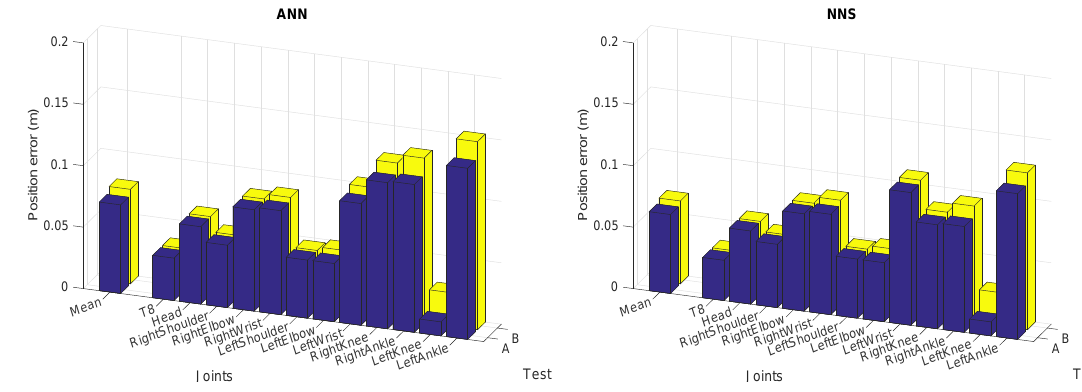
Figure 11. Mean (over all six subjects) joint position error obtained with ANN and NNS when the measured noise was applied to the heading orientation of the inputs. Here, A is the joint position errors obtained with the original input, whereas B is obtained with the measured heading errors applied to the original